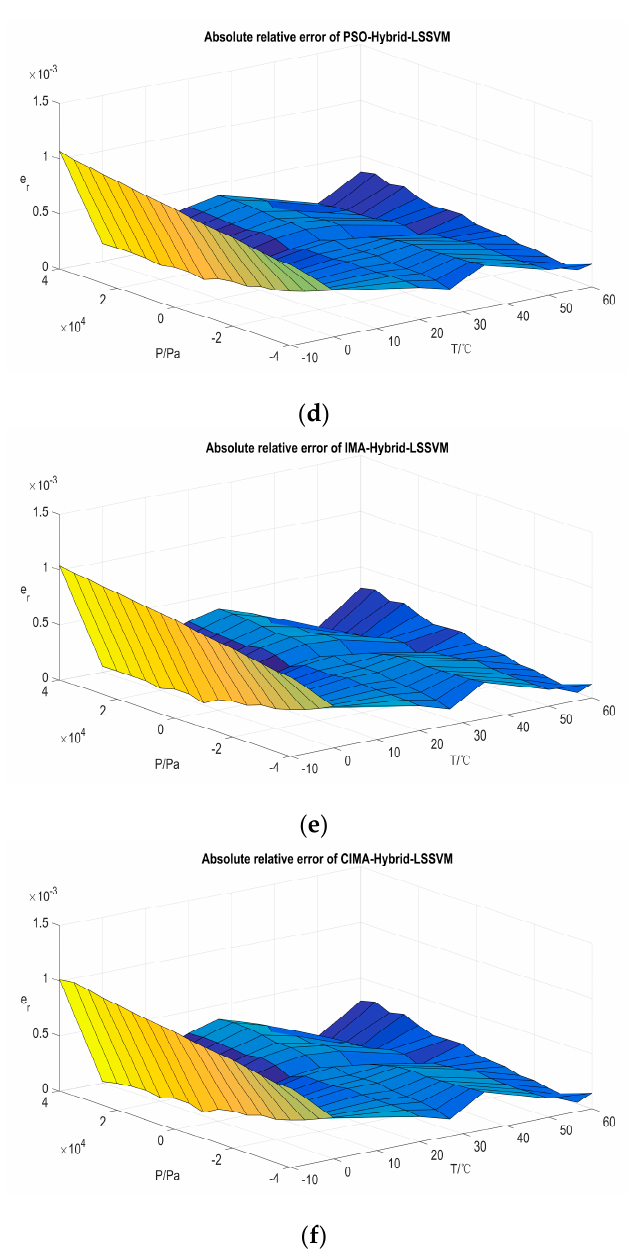
Figure 9. Compensation results on averaged testing set by fixed partition. ( a ) compensation results obtained by SVM; ( b ) compensation results obtained by PSO-RBF-SVM; ( c ) compensation results obtained by PSO-RBF-LSSVM; ( d ) compensation results obtained by PSO-Hybrid-LSSVM; ( e ) compensation results obtained by IMA-Hybrid-LSSVM; and ( f ) compensation results obtained by CIMA-Hybrid-LSSVM.